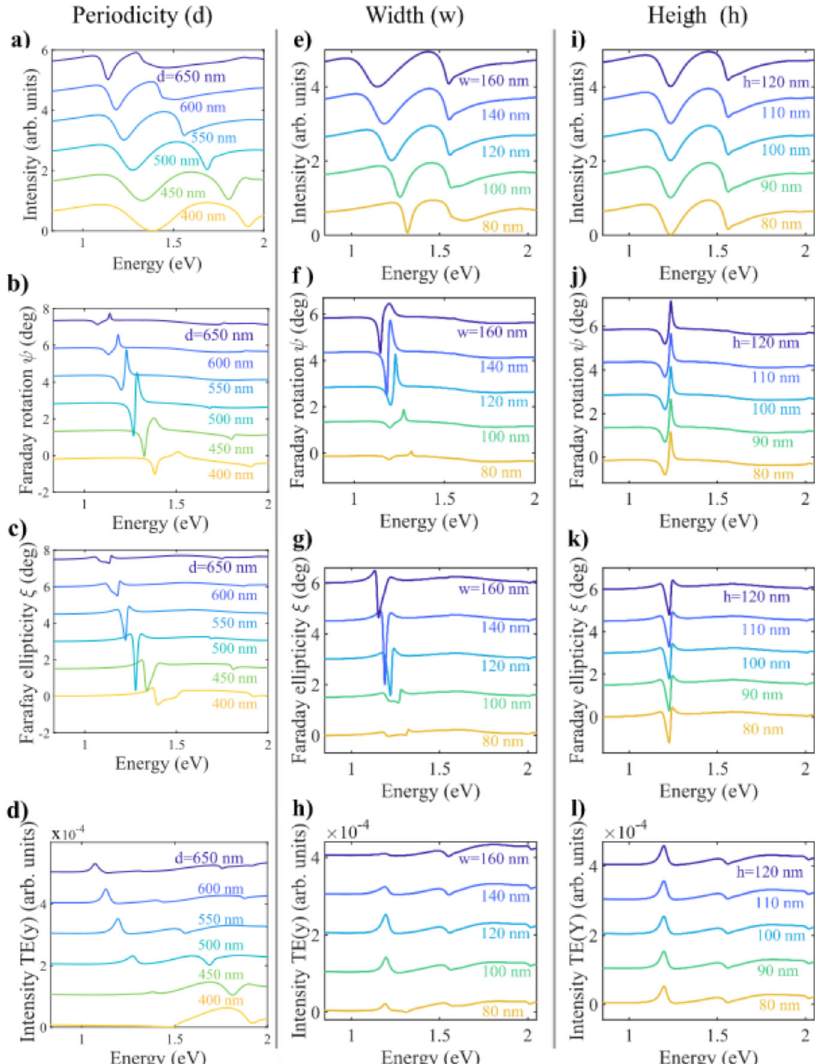
Fig. 4 The dependence of the enhanced Faraday rotation and ellipticity on the geometrical parameters of the waveguide magneto-plasmonic crystal (WMPC) system with transverse magnetic (TM) polarized excitation. The fi nite element method (FEM) simulated transmission spectra, the spectral variation of the Faraday rotation ψ , ellipticity ξ , and the transmitted transverse electric (TE) polarization intensities of the WMPC are shown for varying periodicity ( d , a , b , c , d ), width ( w , e , f , g , h ) and height ( h , i , j , k , l ) of the gold (Au) gratings (shown for E ¼ _ ω ¼ 0 : 83to2 : 067eV) here ħ is the reduced Planck ’ s constant and ω is the frequency. Simultaneous excitation of waveguide and plasmon leads to the formation of hybrid plasmon-waveguide modes and consequently two dips appear in the transmission spectra ( a , e , i ). Large enhancements of the Faraday rotation ( b , f , j ) and ellipticity ( c , g , k ) are observed around the transmission dip at the lower frequency end. The spectral variation of the transmitted transverse electric (TE) polarization intensities ( d , h , l ) are also shown for each of the varying geometrical parameters of the WMPC. The periodicity ( d ) parameter of the grating is varied from 400 to 650 nm with a step size of 50 nm, keeping fi xed width (w = 120 nm ) and height ( h = 100 nm). Similarly, the w parameter of the grating is varied from 80 to 160 nm in a step of 20 nm with a fi xed d = 550nm and h = 100 nm. The h parameter is increased from 80 to 120 nm with a step of 10 nm for a fi xed d = 550 nm and w = 120 nm. In order to maintain clarity in the fi gures, the baselines of each of the spectra are shifted. In order to maintain clarity in the fi gures, the baseline magnitudes of Faraday rotation ψ and ellipticity ξ are shifted by (cid:4) 1.5 deg. consecutively for each sub-plot with varying periodicity, width and height of the Au